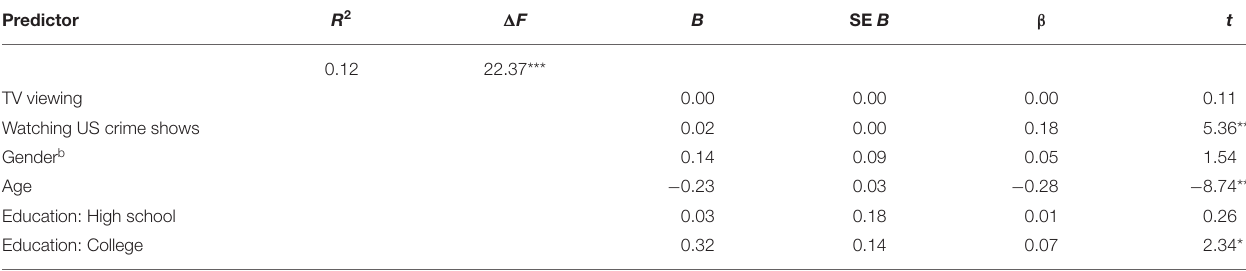
TABLE 4 | Results of multiple linear regression analysis to predict perceptions of the death penalty a among study participants.